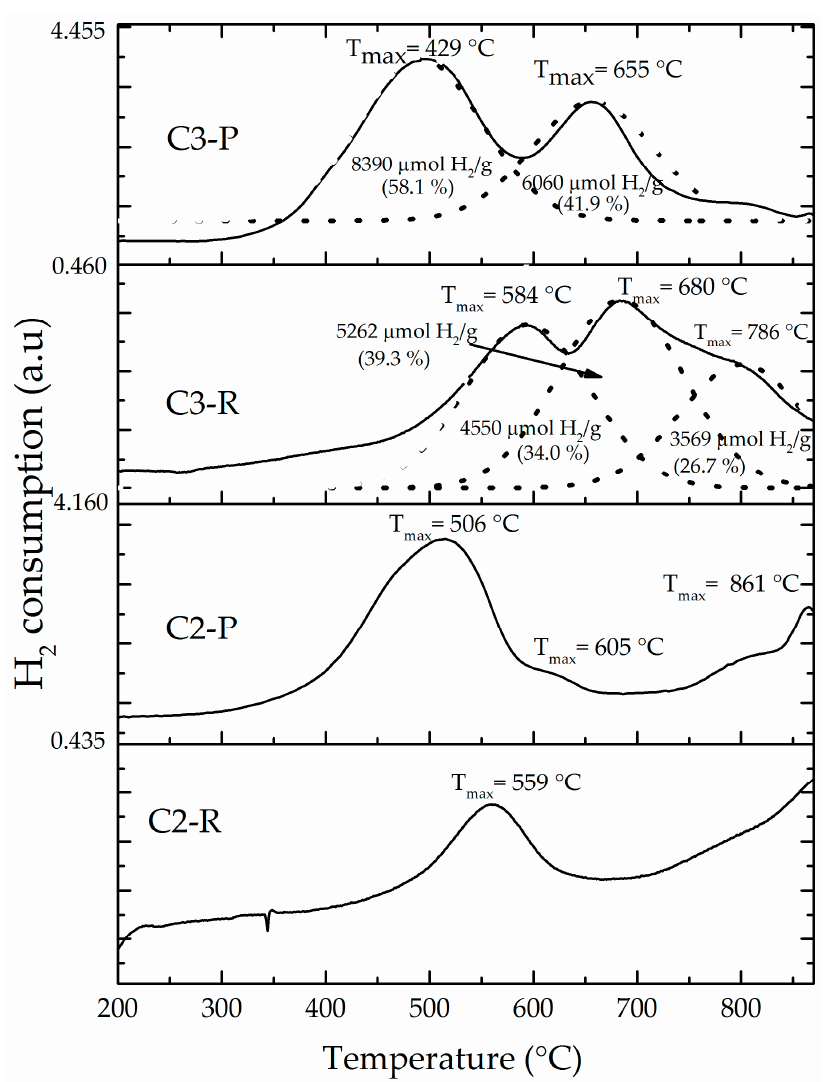
Figure 6. Hydrogen–temperature programmed reduction (H 2 –TPR) of refined (R) and pillared forms of clays C2 and C3: Solid lines are experimental curves and dotted lines Gaussian fitted curves of C3-derived materials.